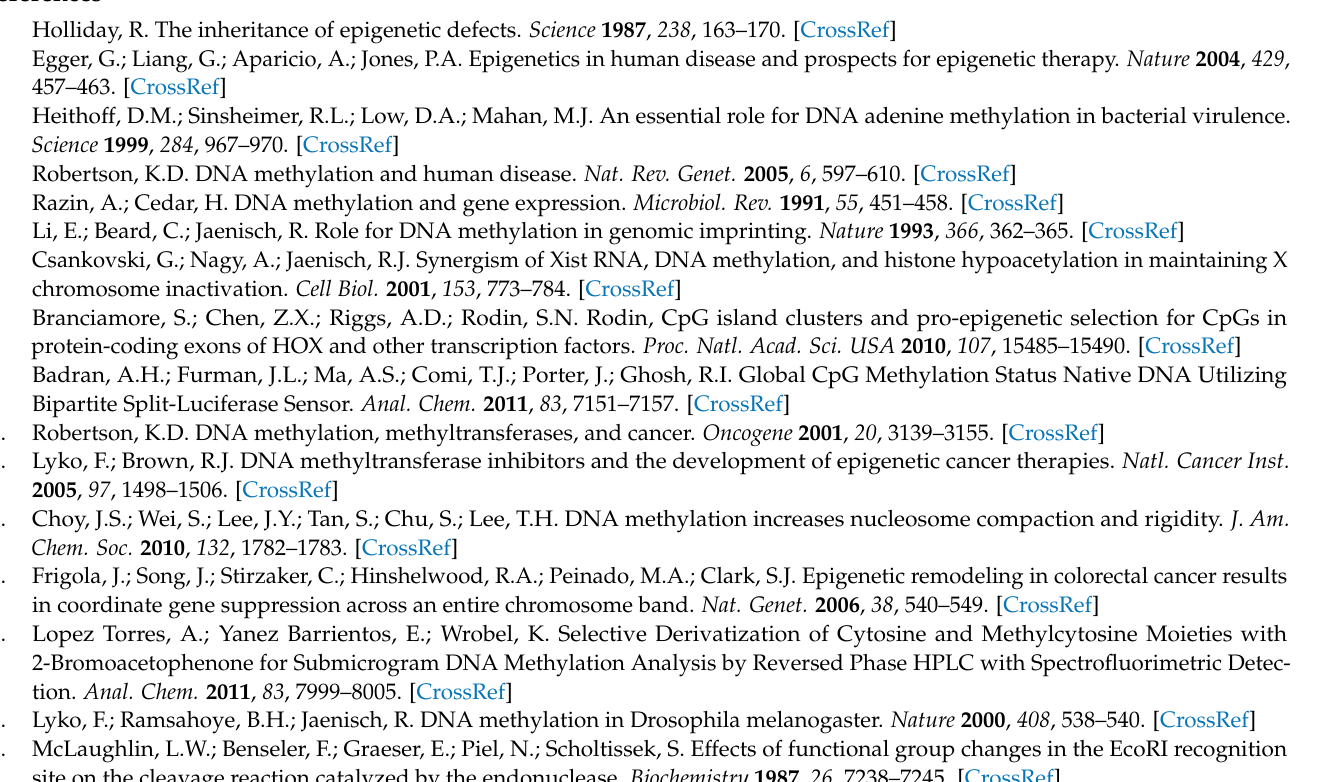
Figure S2: Cyclic voltammograms of the different modified electrodes in 0.1 M Tris-HCl buffer solution containing 5 mM (1:1) [Fe(CN) 6 ] 3 − /4 − : the MB labeled Fc-Ab/H1/H2/GE (red curve), the MB unlabeled Fc-Ab/H1/H2/GE (black curve); Figure S3: SWV curves for the same concentration of Dam MTase HaeIII MTase and M.SssI MTase; Figure S4: SWV curves for the different storage time